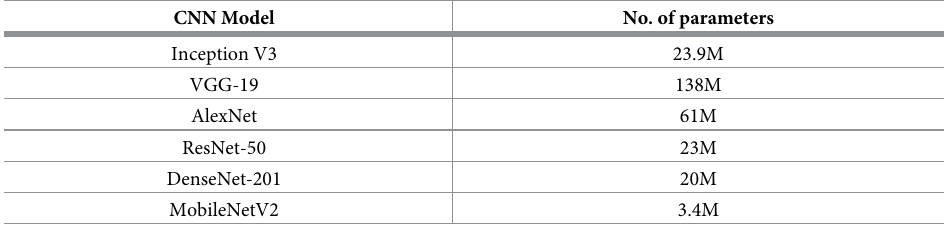
Table 1. Comparison of the well-known CNN models used in deep transfer learning on the number of